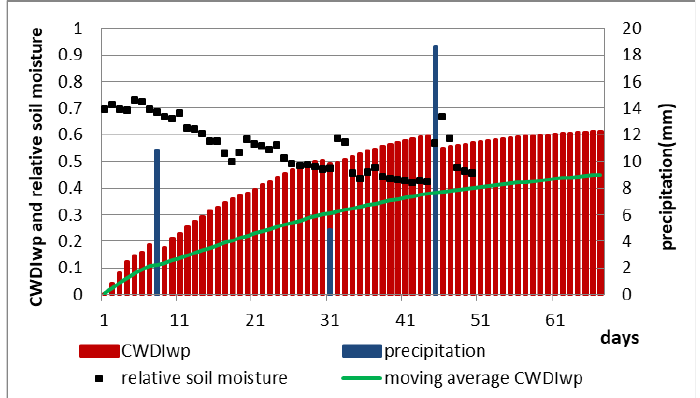
Figure 4. Development of a maize drought disaster at Fuxin station in 2006.